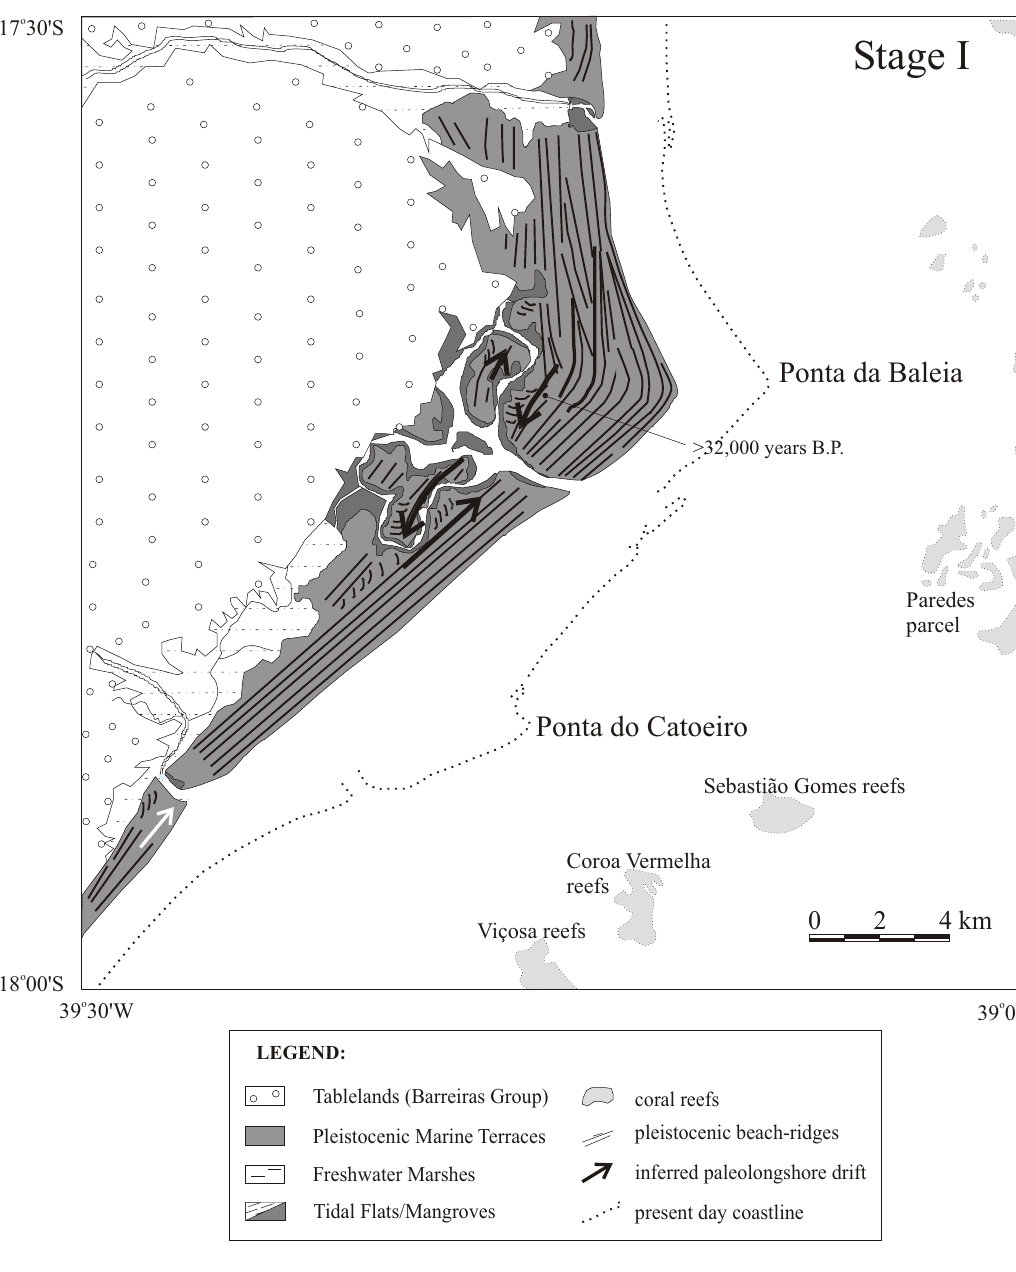
Fig. 9 – Quaternary evolution of the Caravelas strandplain: Stage I – Construction of the Pleistocene strandplain – after 120,000 years